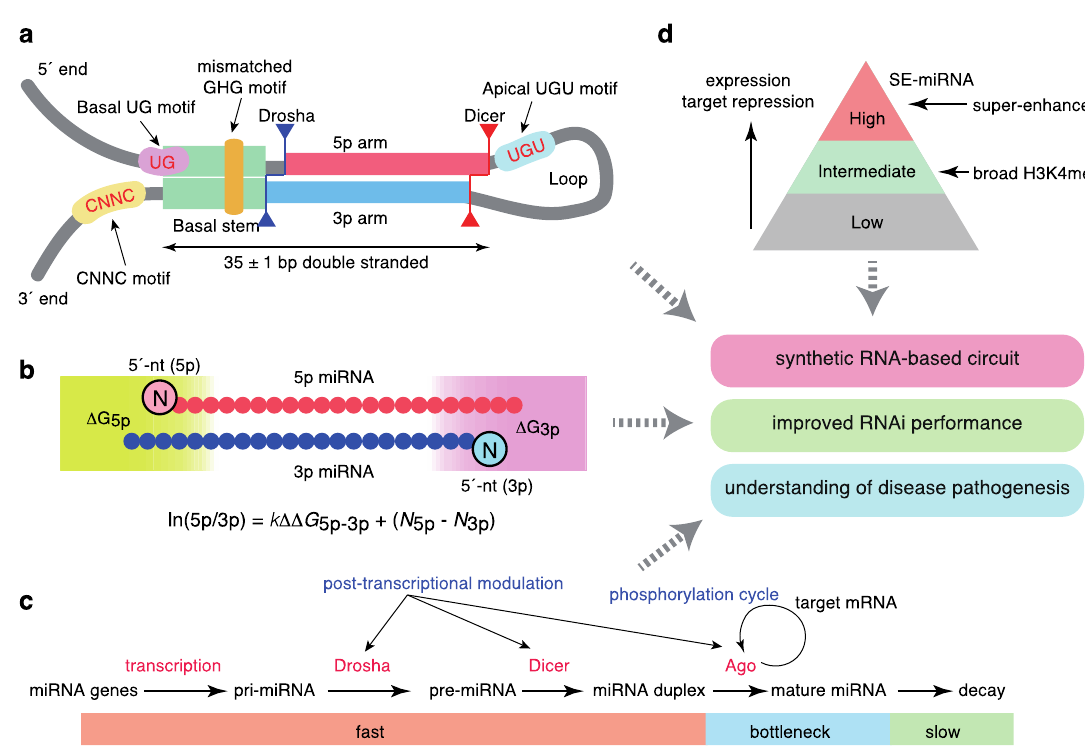
Figure 2. Quantitative features of miRNA homeostasis. ( a ) Sequence features that define pri-miRNAs. ( b ) Molecular principles of asymmetric strand selection. ( c ) Dynamics of miRNA metabolism and broad post-transcriptional regulation. ( d ) Relationships between super-enhancers and the hierarchy of the miRNA network.